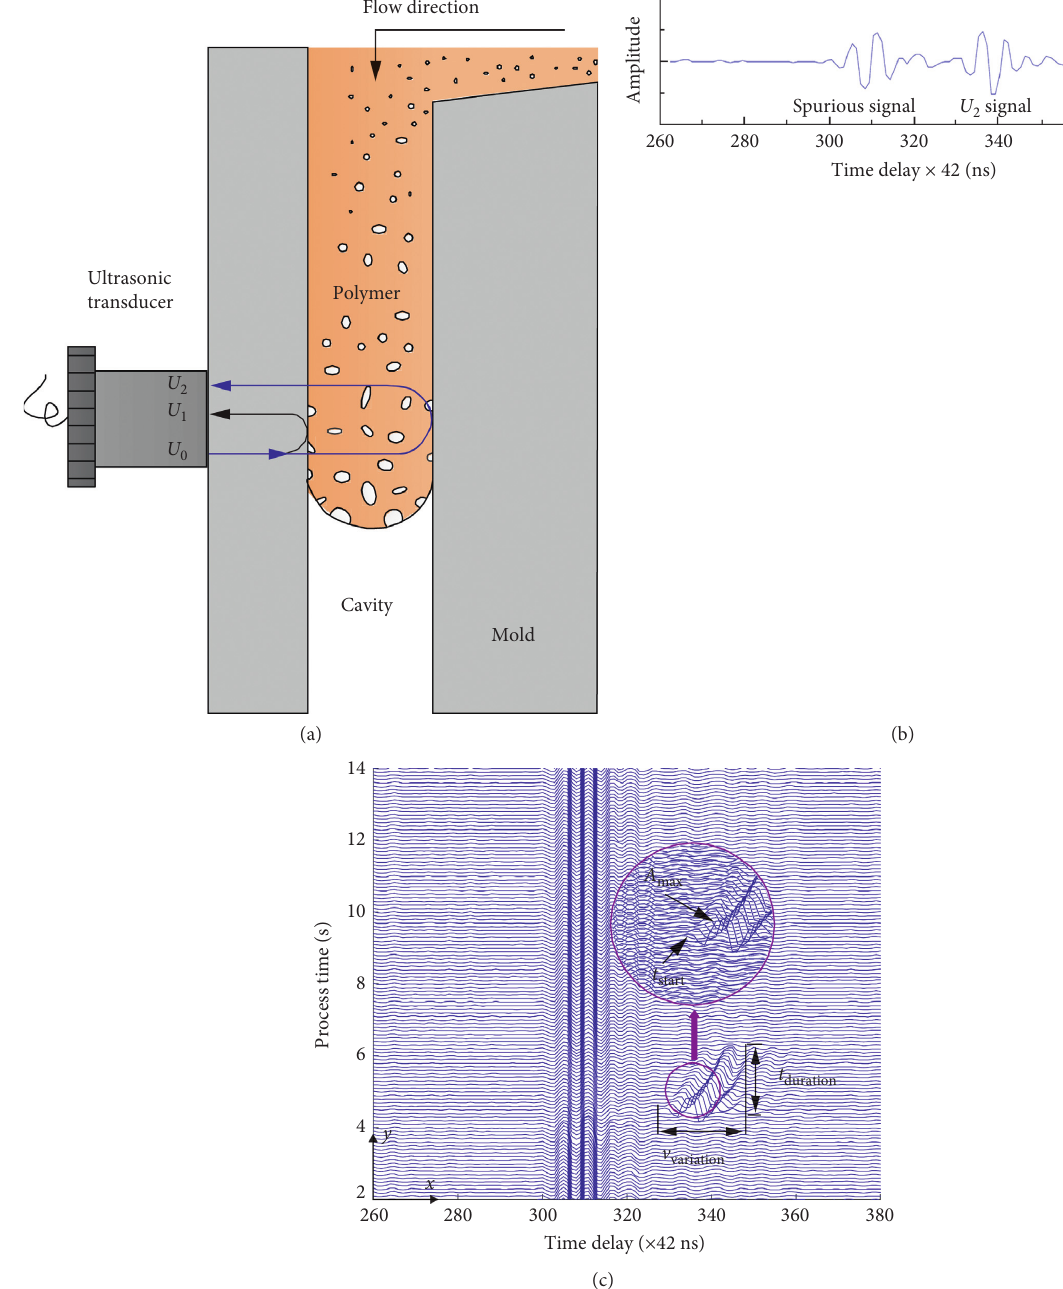
Figure 5: An ultrasonic pulse-echo measurement method for online characterization of (a) a cross-sectional schematic view of a mold with an ultrasonic transducer, (b) a typical single signal received with the transducer, and (c) typical U2 ultrasonic signals over a microcellular injection molding (MIM) process cycle